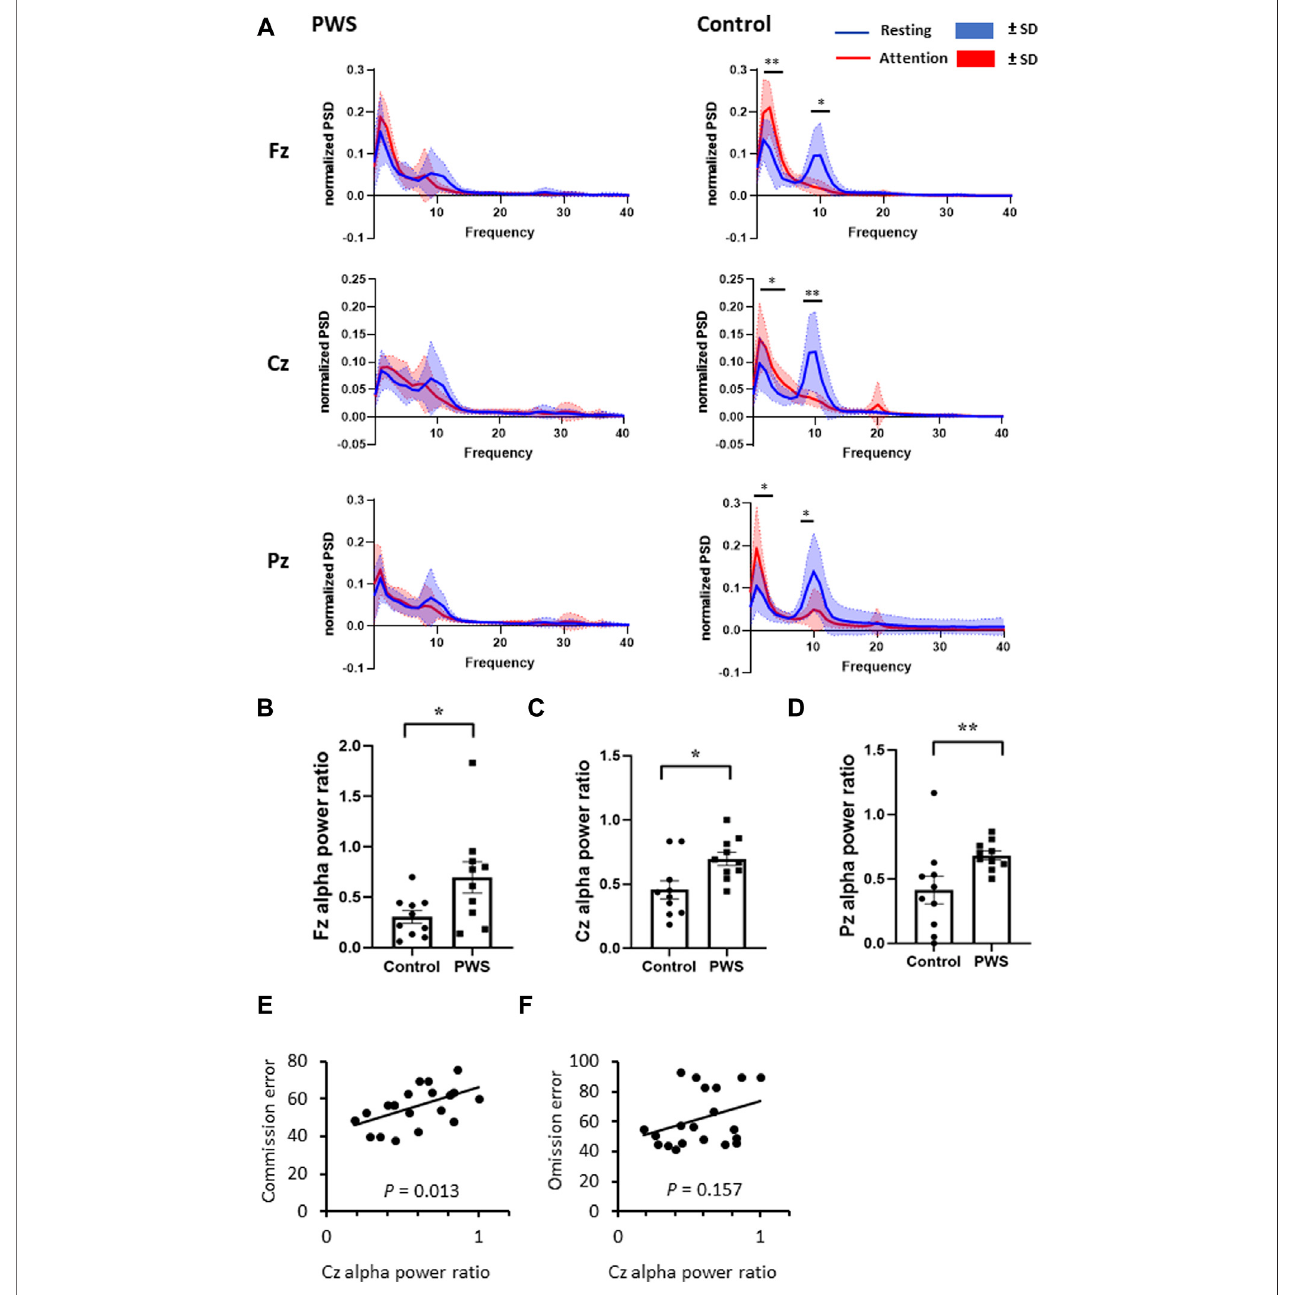
FIGURE 2 | Dynamic changes in the quantitative electroencephalographic (EEG) spectrum between an attention task and the resting state. (A) Normalized EEG power spectrum density during attention tasks and resting state in patients with PWS and control participants. The control participants presented with an increased delta-to-theta power and a decreased alpha power while engaging in attention tasks. (B – D) The attention-to-resting alpha power ration were smaller in control participants at Fz (B) , Cz (C) , and Pz (D) regions. (E, F) For all participants, including patients with PWS and participants, the attention-to resting Cz alpha power ratio positively correlated with the T-scores of commission error (E) but not with omission error (F) .